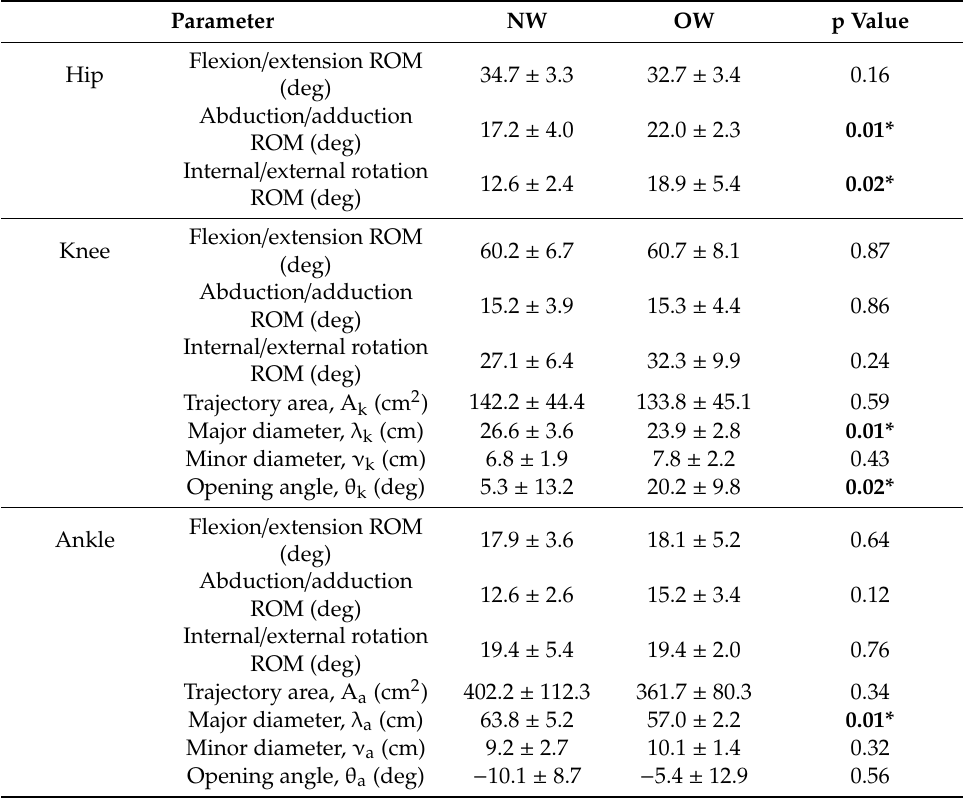
Table 3. Joint kinematics parameters (mean ± standard